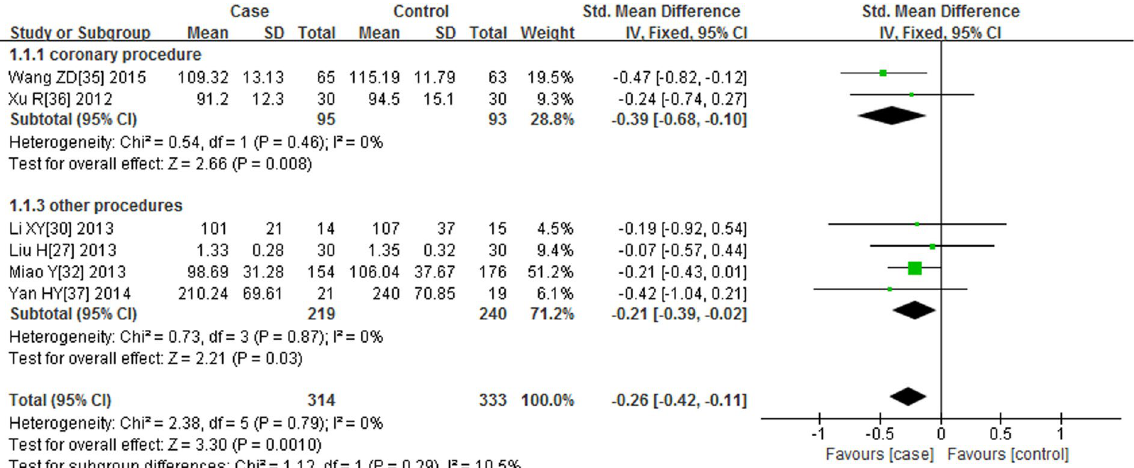
Figure 3. Forest plot of the association between using of alprostadil and the Scr level 24 hours after the contrast was administered, the horizontal lines correspond to the study-specific SMD and 95% CI, respectively. The area of the squares reflects the study-specific weight. The diamond represents the pooled results of SMD and 95% CI.